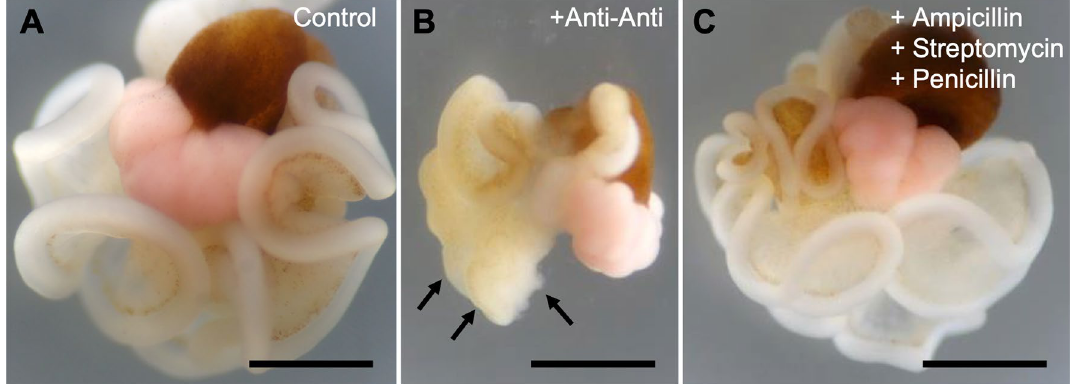
Figure 2. Effects of a commercially available antibiotic–antimycotic solution or antibiotics on mesenterial tissue. ( A ) Brightfield view of mesenterial tissue maintained in FSW for 3 days (Control). ( B ) Mesenterial tissue maintained in FSW supplemented with antibiotic–antimycotic solution (Anti–Anti, from Thermo Fisher Scientific) for 3 days. ( C ) Mesenterial tissue maintained in FSW supplemented with 50 μg/mL ampicillin, 50 U/ mL penicillin and 50 μg/mL streptomycin for 3 days. Note that addition of Anti–Anti induced deformation of mesenterial tissues (arrows). Scale bars = 1